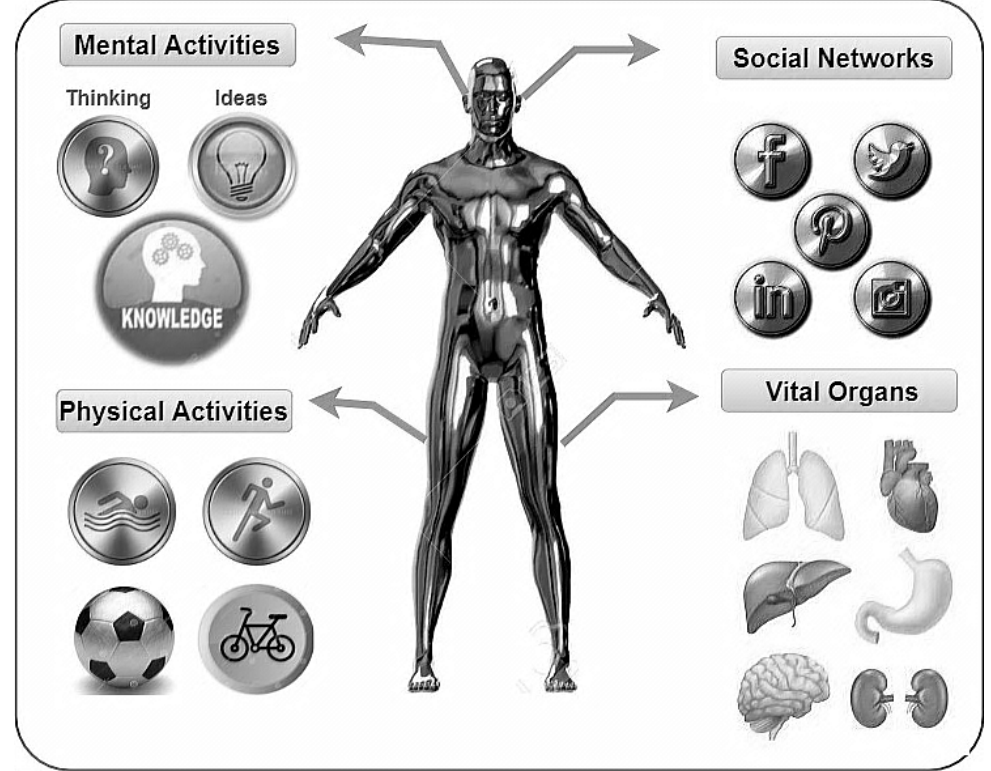
Figure 2. Our comprehensive personal digital twin definition including mental activities, physical activities, social networks, and vital